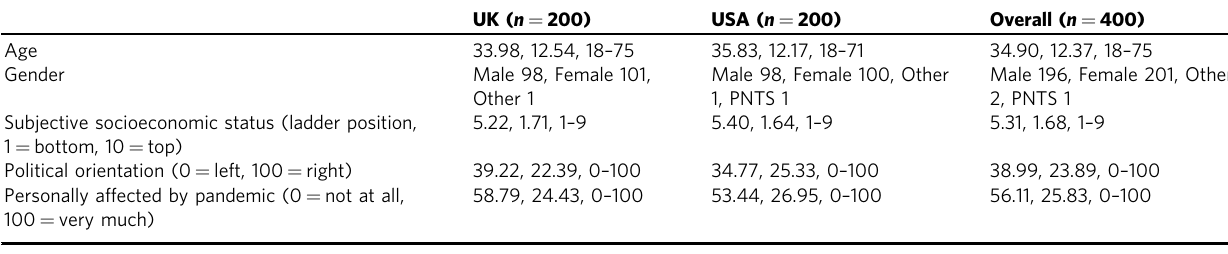
Table 2 Sociodemographic statistics for the respondent samples for study